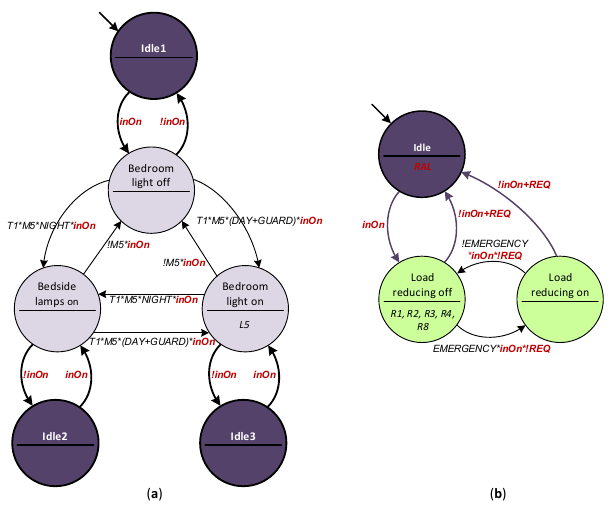
Figure 13. SHS—the “Process” master FSM.